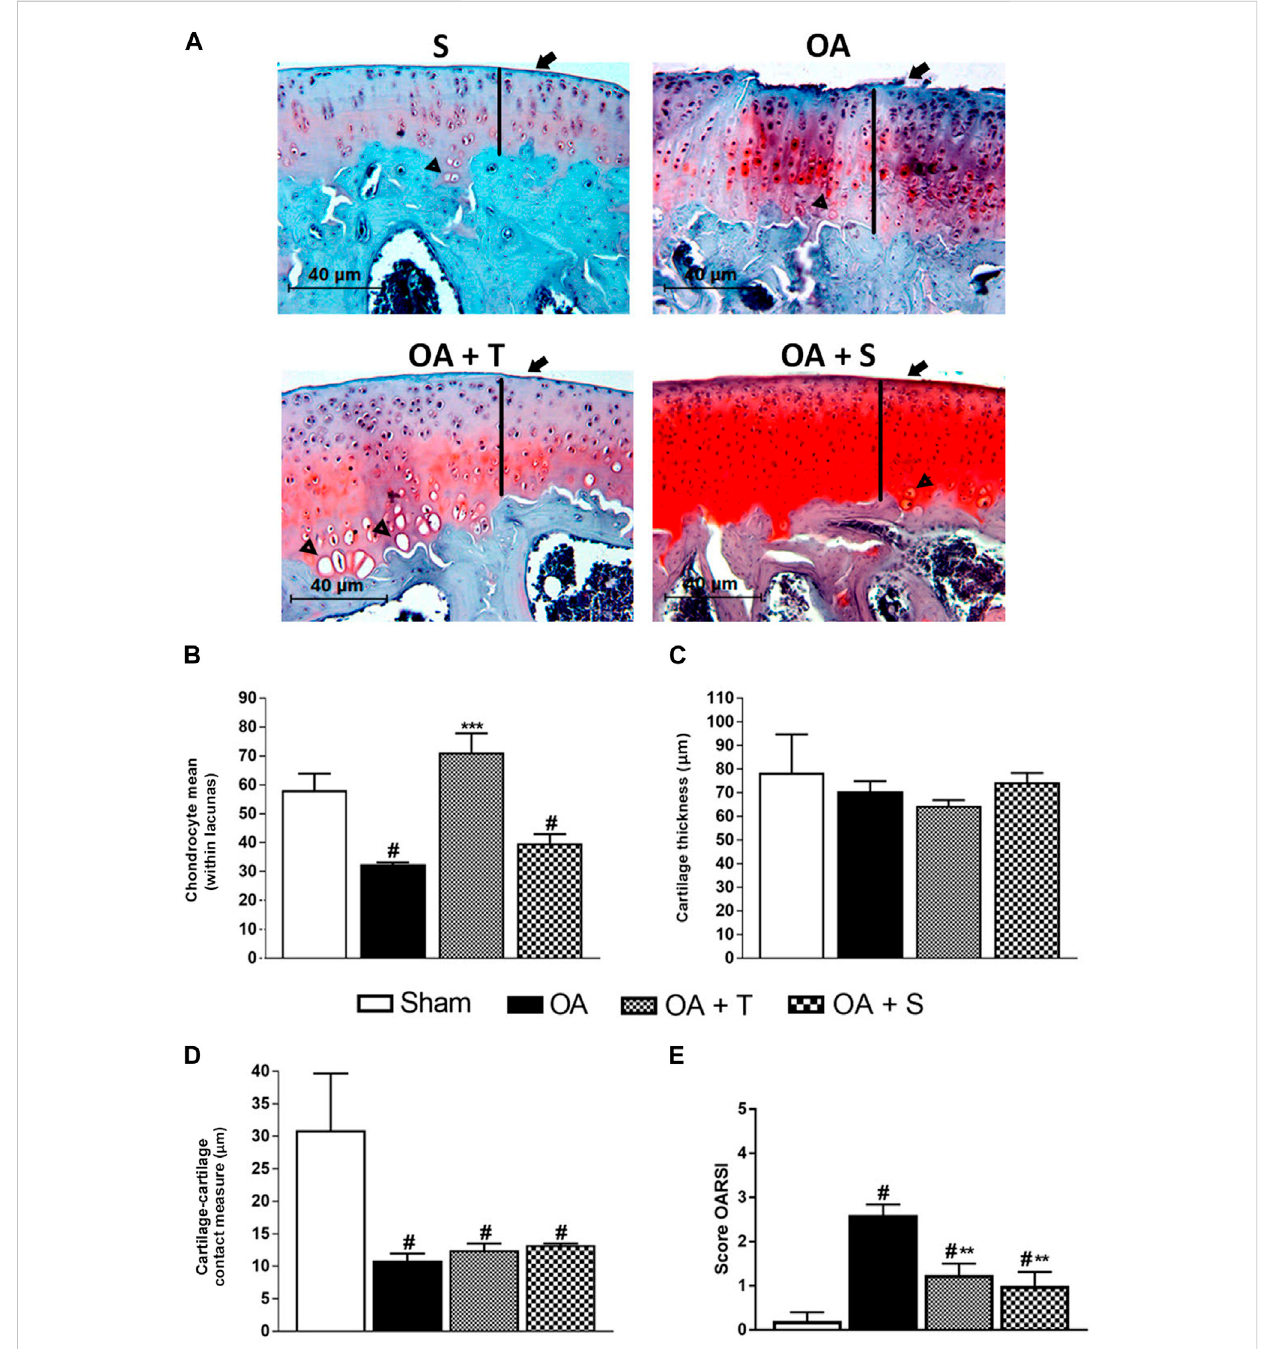
FIGURE 7 Histologicalanalysis. (A) RepresentativeimageswhereArrows=surfacecartilagethickness;Arrowhead=chondrocytesinsidethelacuna;Blackline= cartilagethickness; (B) Chondrocytemean; (C) Cartilagethickness; (D) Cartilage-cartilagecontact; (E) ScoreOARSI.Dataarepresentedasmean± SEM,in which: # p < 0.05 v.s Sham Group; *** p < 0.001 v.s OA Group; (One-way ANOVA followed by Tukey post hoc